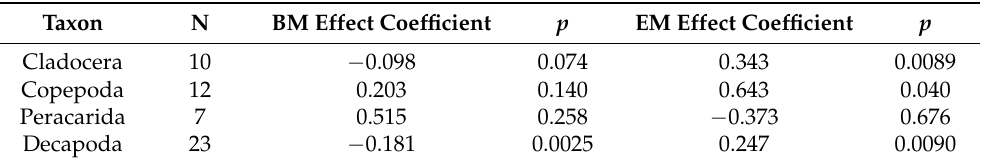
Table 3. General linear model (GLM) analyses for scaling relationships between log 10 -transformed values of genome size (pg) versus wet body mass (BM, mg) and wet egg mass (EM, mg) for each of four major crustacean taxa 1